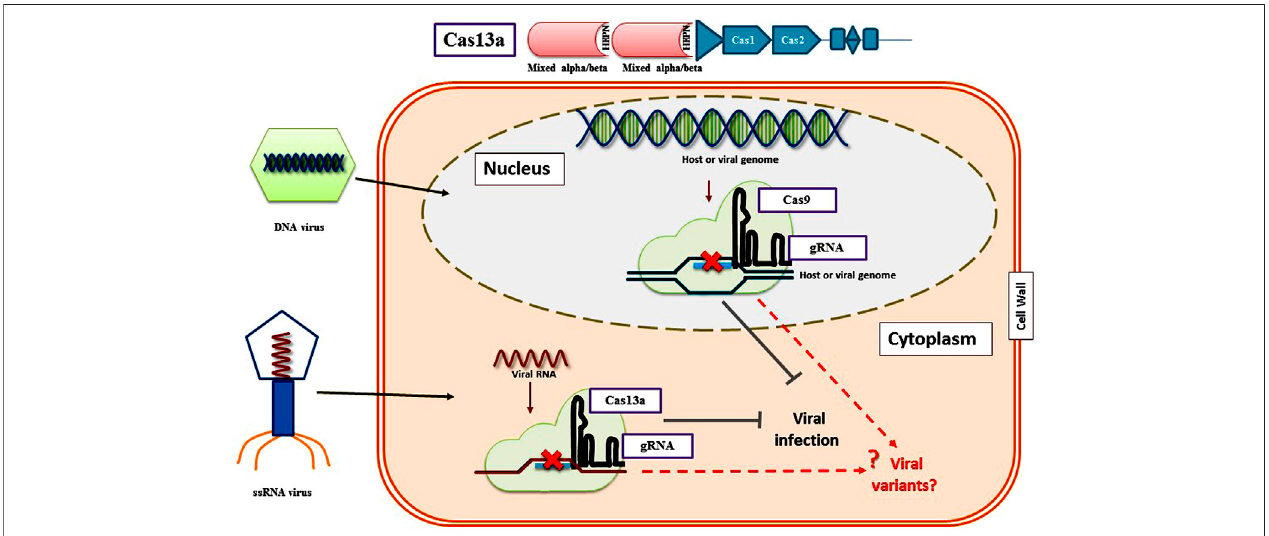
FIGURE4| RNAvirusinterferenceviaCRISPR/Cas13asysteminplants.TheseCas13proteinstargetRNAmoleculesinsteadofDNA.Cas13aguidedbyacrRNA containinga28-ntspacersequencecleavestargetssRNAs invitro and invivo withaprotospacer fl ankingsequence(PFS)ofA,U,orC,CRISPR/Cas13aknockdownthe viral RNA located in plant nuclei. Cas13a can also target multiple RNA transcripts simultaneously using different crRNAs. Moreover, CRISPR/Cas13a system could be used to target a speci fi c RNA in a particular tissue by providing a tissue-speci fi c promoter.